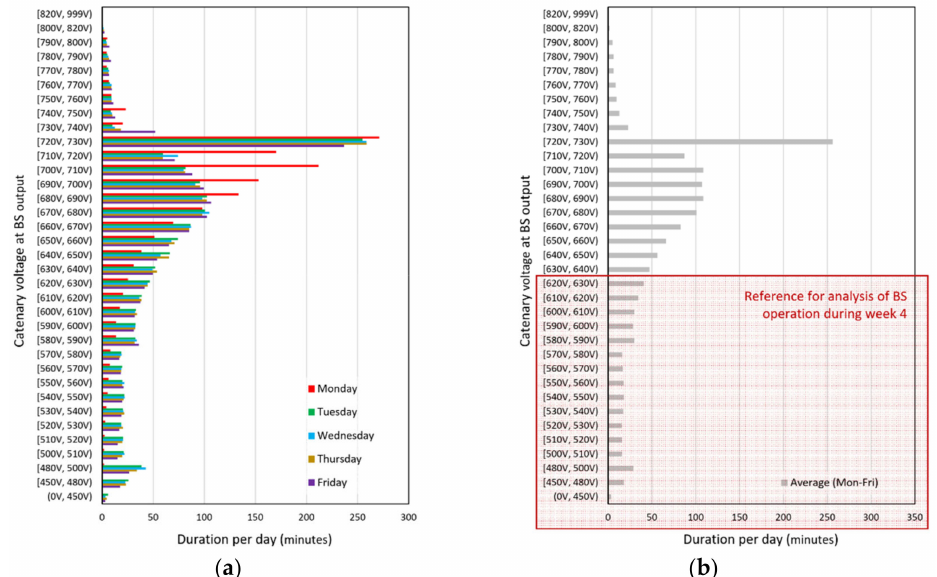
Figure 4. Buffer station output voltage histograms for week 3 (BS inactive): ( a ) daily histograms for particular weekdays; ( b ) averaged weekly histogram (reference for week